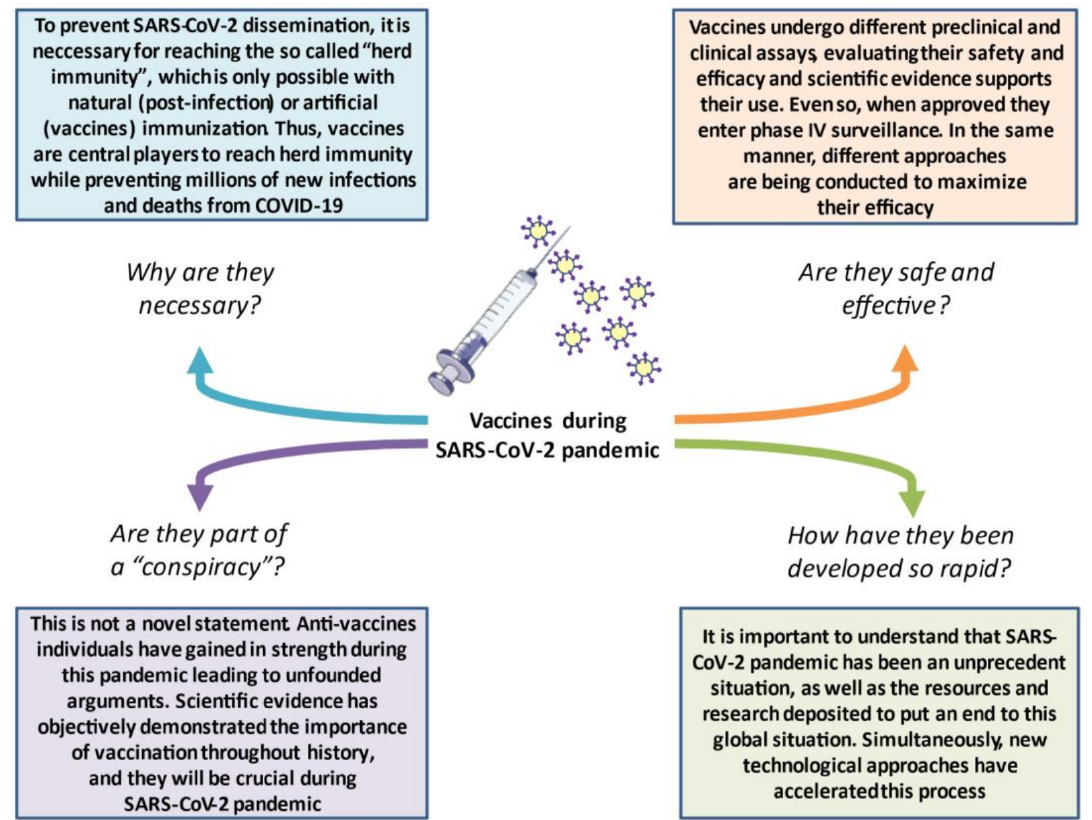
Figure 1. The role of vaccines during the SARS-CoV-2 pandemic and the main concerns in the general population. The proper communication and exposition of the main concerns regarding vaccination are crucial for ending this global